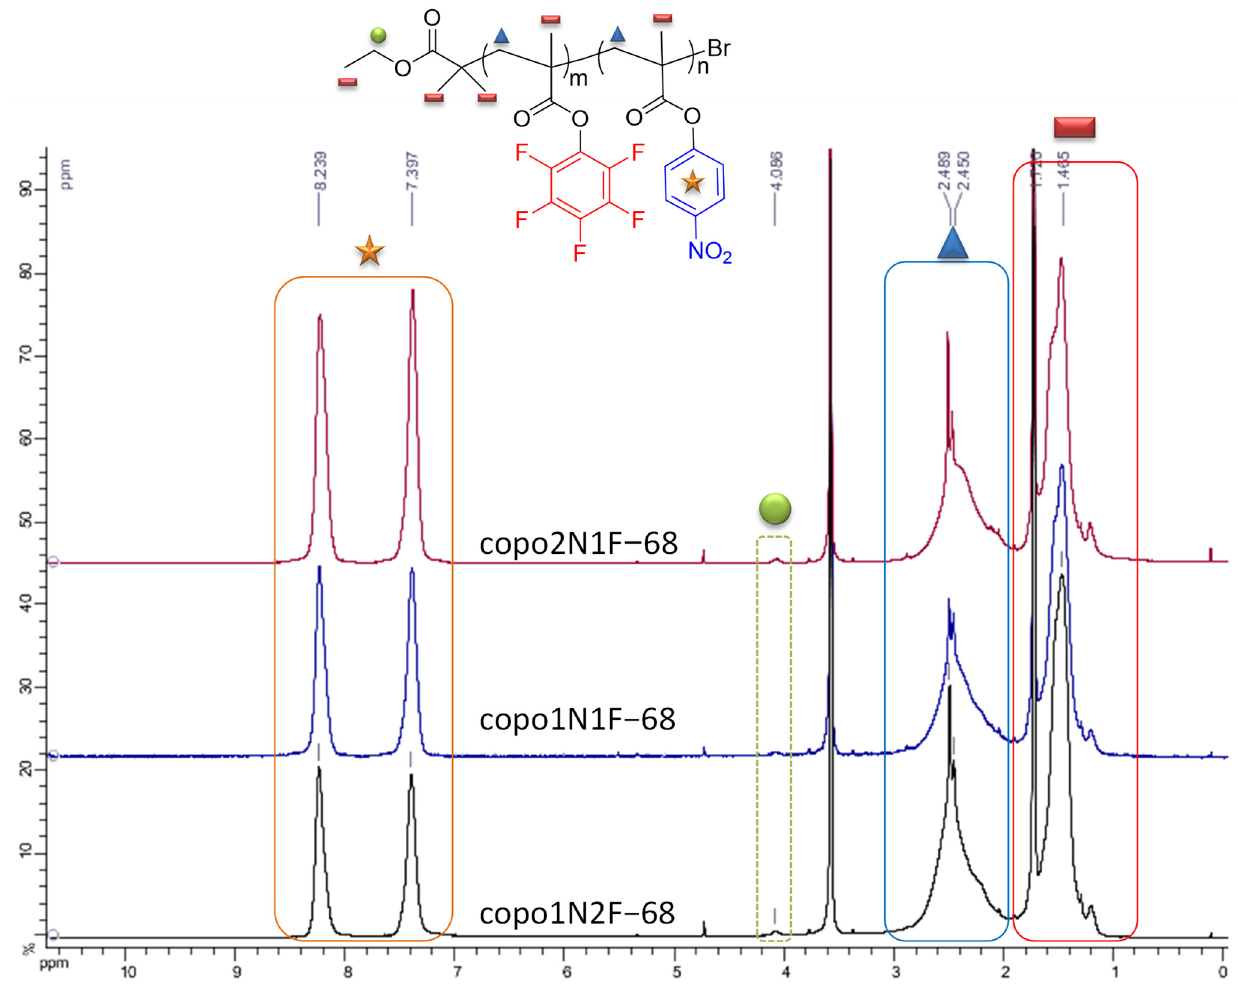
Figure 1. 1 H NMR spectra of copolymers of NPMA and PFPMA obtained by Cu(0)-mediated RDRP at different compositions (THF-d 8 , 360 MHz), at 68 h of polymerization.